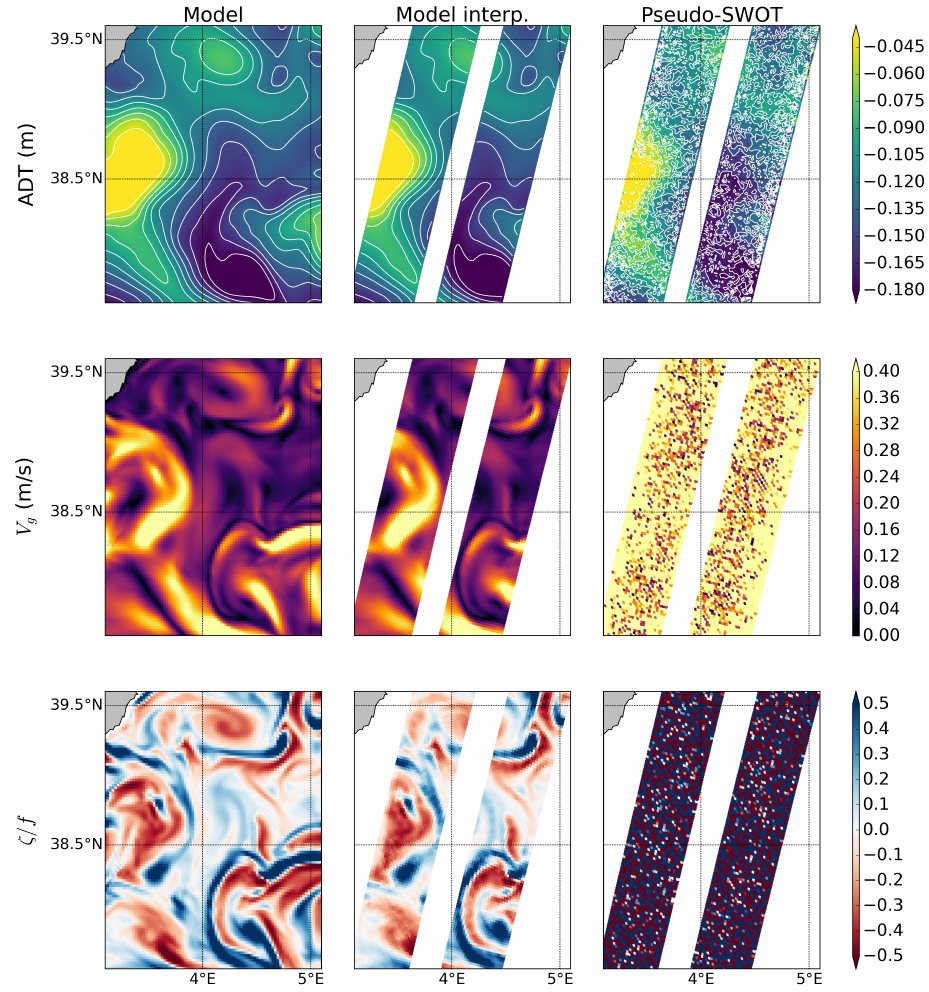
Figure 5. From top to bottom: SSH (m), geostrophic velocity (m/s) and relative vorticity ( ζ ) normalized by f, on 3 February 2009 corresponding to pass 168 of cycle 2 (box 2). The first, middle and last columns show the data obtained directly from the model (WMOP), from the model interpolated onto the SWOT grid (SSH model ), and with added noise (SSH obs ),